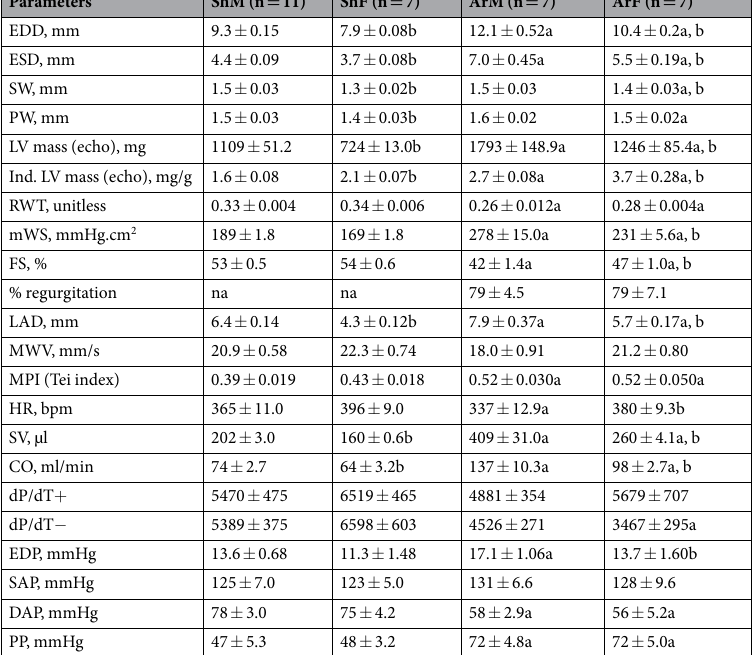
Table 2. Echocardiography data and hemodynamic values. EDD: end-diastolic diameter, ESD: end-systolic diameter, SW: septal wall thickness, PW: posterior wall, Ind: indexed, RWT: relative wall thickness, mWS: mean LV wall stress, FS: fractional shortening, LAD, left atrial diameter, MWV: LV mid-wall velocity, MPI: myocardial performance index, HR: heart rate, bpm: beats per minute, SV: stroke volume, CO: cardiac output, dP/dt + and dP/dt − , maximal and minimal derivative of pressure/time, EDP: LV end-diastolic pressure, SAP: systolic arterial pressure, DAP: diastolic arterial pressure and PP: pulse pressure. Na: not applicable. Values are expressed as the mean ± SEM. The number of animals per group is indicated in parentheses. a p < 0.05 vs. the corresponding sham group and b p < 0.05 vs. the corresponding male group. Echocardiography measurements were obtained under inhaled isoflurane